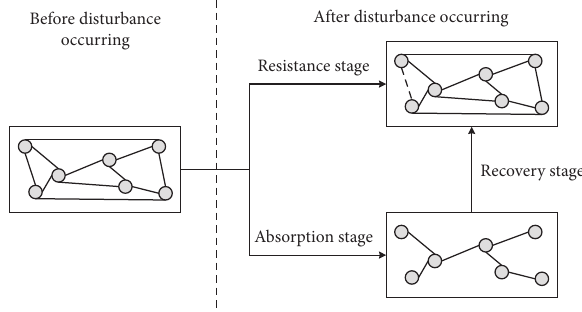
Figure 1: Stages division of cross-city transportation network